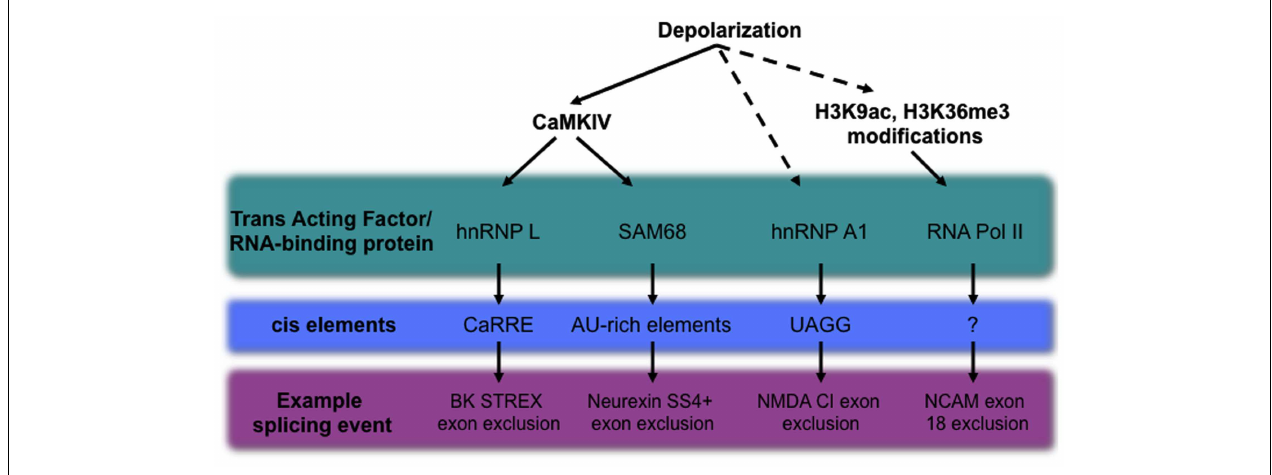
FIGURE 2 | Mechanisms of depolarization-dependent alternative splicing, including known trans-acting factors, the cis -elements with which they interact, and a representative alternative splicing event